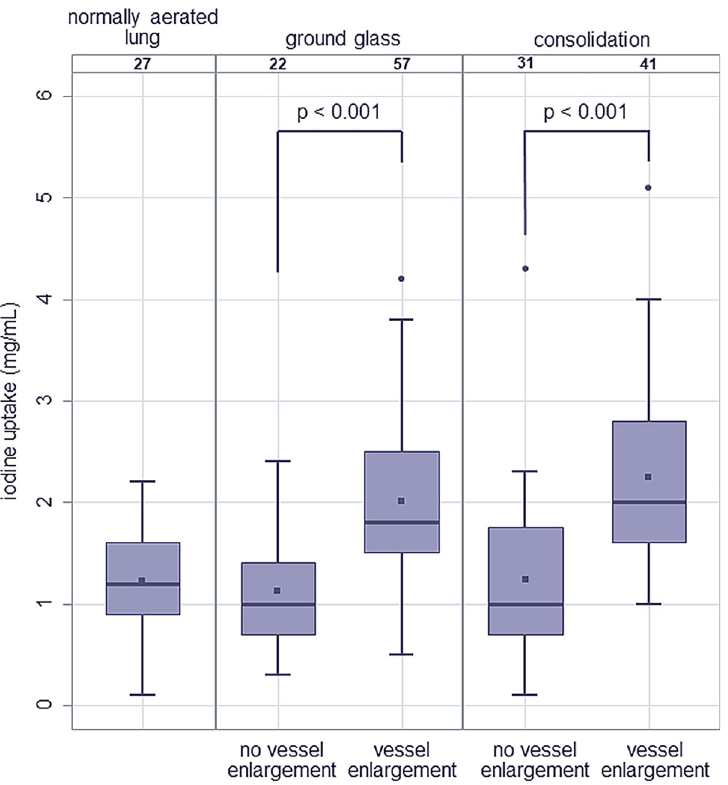
Fig 6. Iodine uptake (mg/mL) of normally aerated lung (estimated mean: 1.22; 95%-CI: 0.95–1.49), areas of ground-glass opacification without and with vessel enlargement (estimated mean: 1.15; 95%-CI: 0.79–1.15; and 2.01; 95%-CI: 1.74–2.28, respectively), and areas of consolidation without and with vessel enlargement (estimated mean: 1.21; 95%-CI: 0.90–1.53; and 2.28; 95%-CI: 1.98–2.57, respectively).